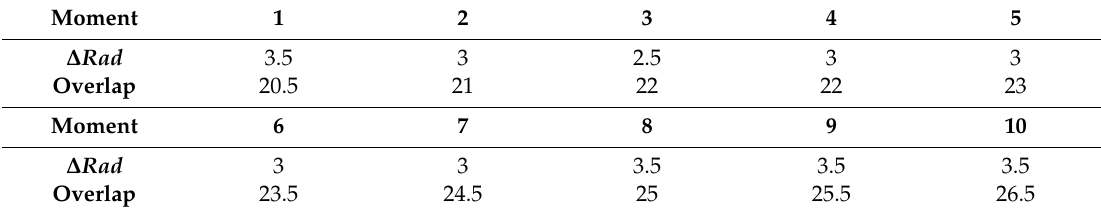
Table 9. The di ff erence of danger sectors before and after considering manoeuvrability in a crossing encountering